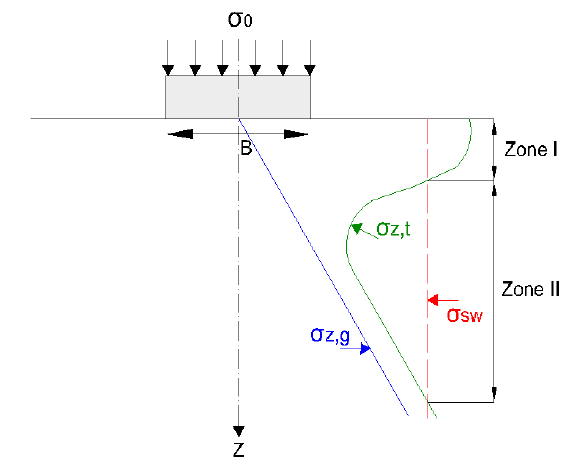
middle of each elementary layer under the center of the foundation. Figure 4: Scheme of stresses distributions in the soil below a Figure 4: Scheme of stresses distributions in the soil below a shallow foundation shallow foundation.